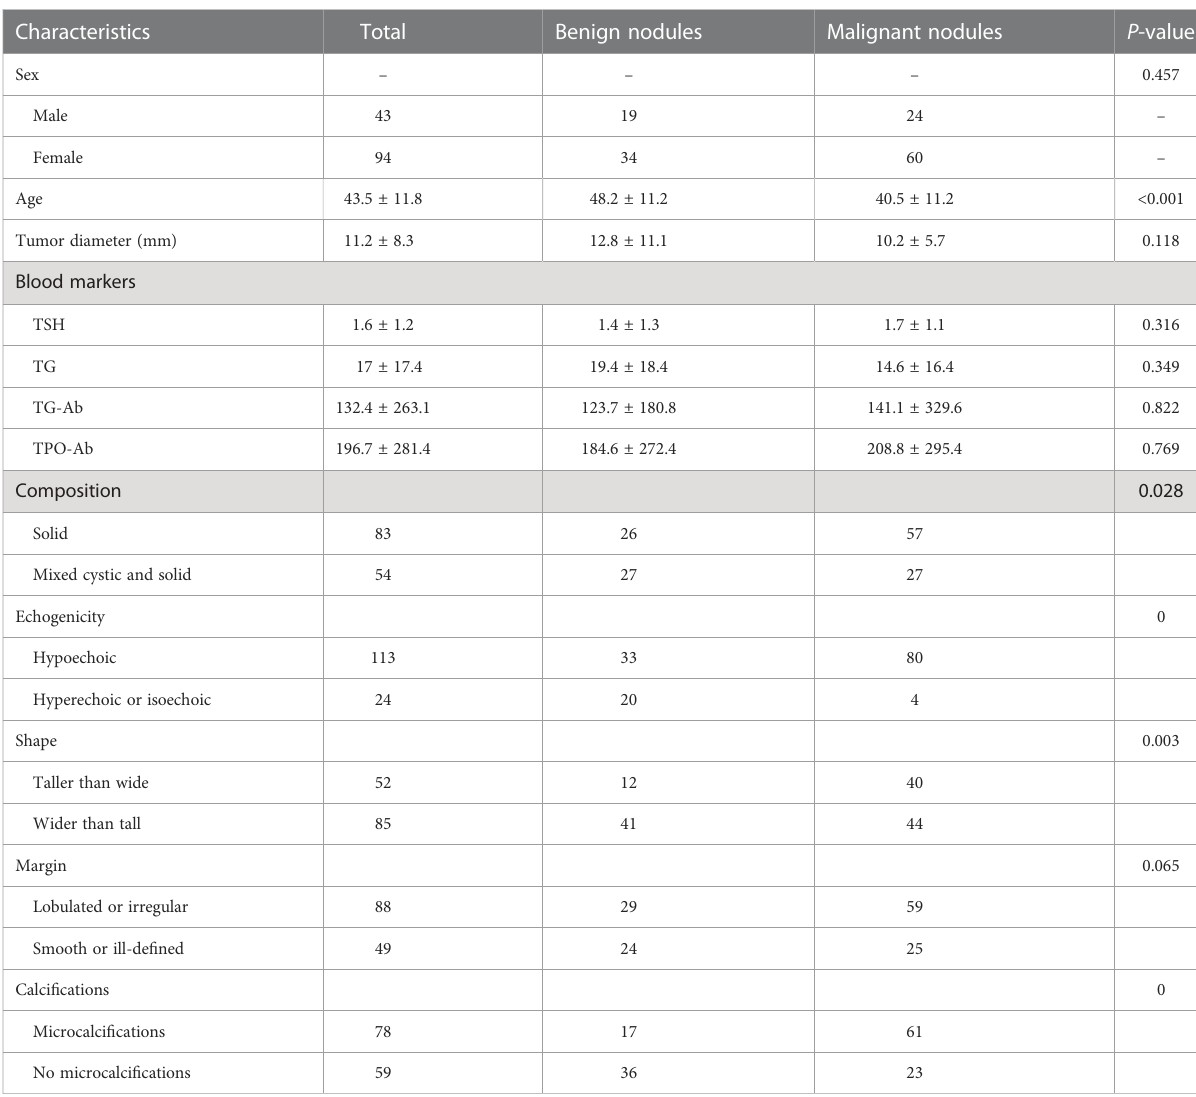
TABLE 1 The characteristics of patients and